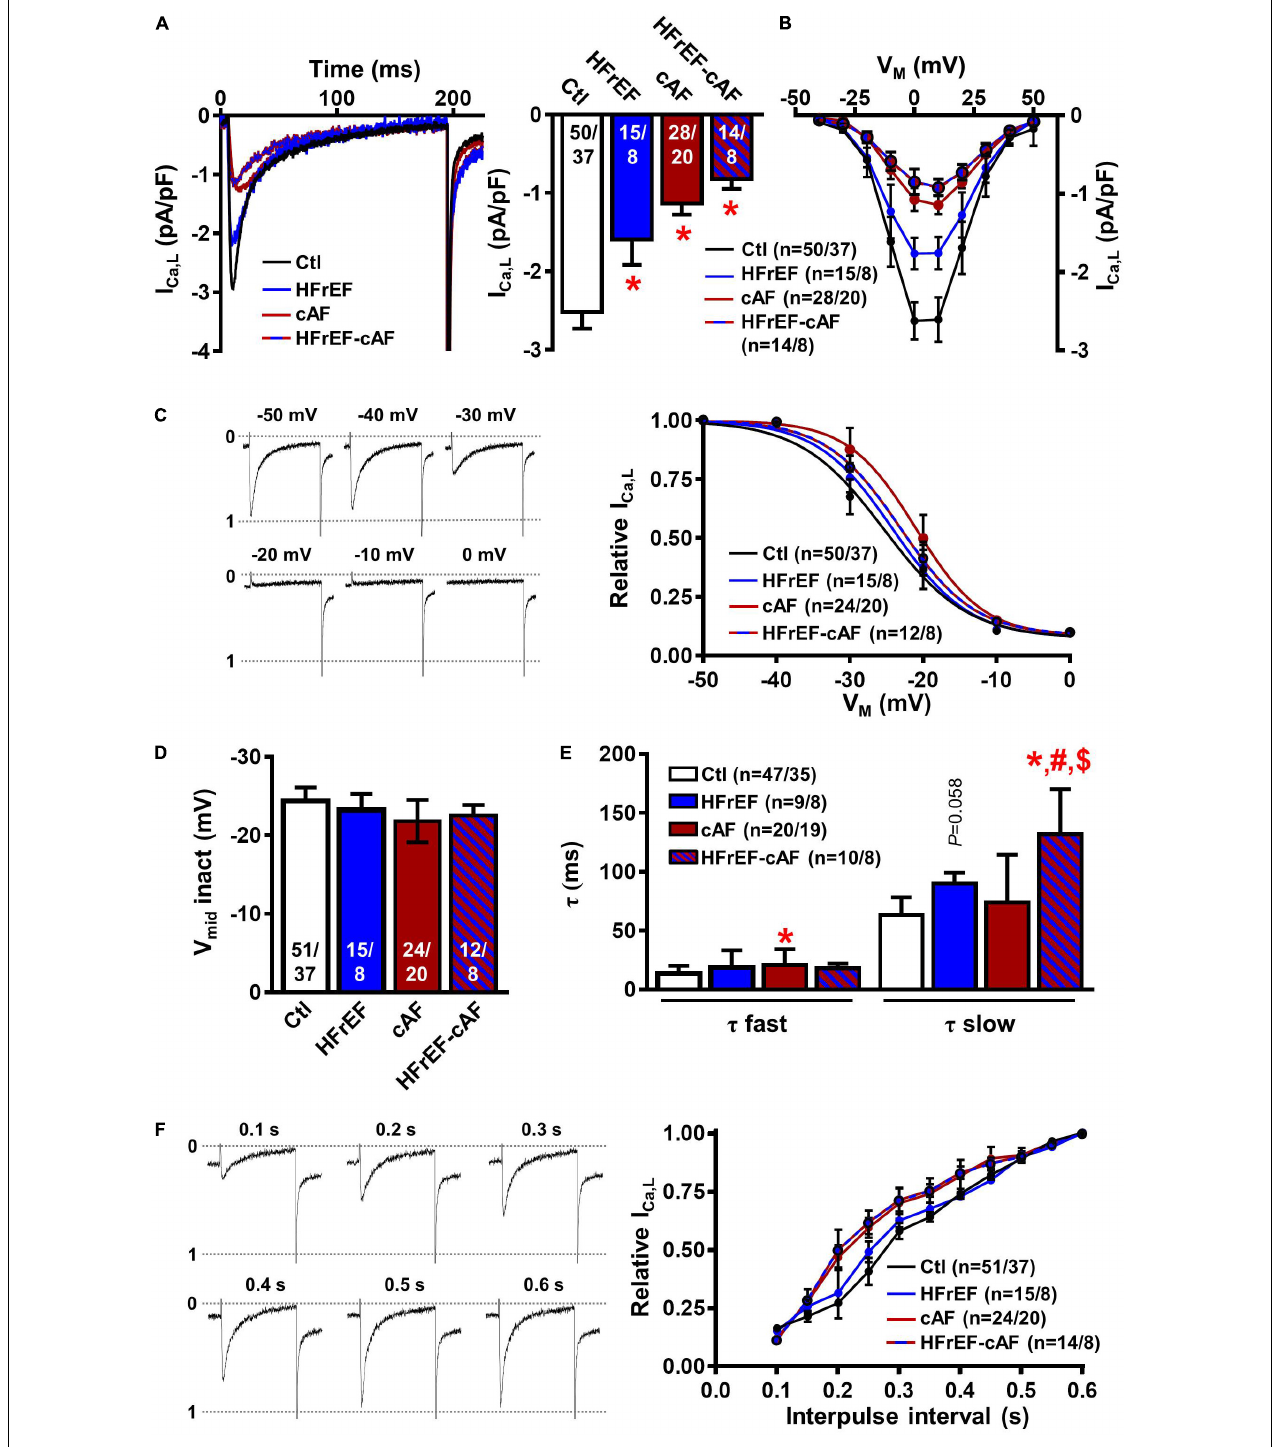
FIGURE 3 | L-type Ca 2 + current (I Ca , L ) measurements in isolated human atrial cardiomyocytes. (A) Representative I Ca , L recording during a 200-ms depolarizing pulse to +10 mV in a Ctl (black), HFrEF (blue), cAF (red) or HFrEF-cAF (blue/red) atrial cardiomyocyte (left) and quantification of I CaL amplitude (right). (B) Current-voltage relationship of peak I Ca , L . (C) Representative examples of I Ca , L inactivation protocol (left) and voltage dependence of inactivation (right) (D) midpoint of inactivation in Ctl, HFrEF, cAF and HFrEF-cAF patients. (E) Fast and slow time constants of inactivation during a depolarization to +10 mV in Ctl, HFrEF, cAF and HFrEF-cAF patients. (F) Representative examples (left) and quantification (right) of I Ca , L recovery from inactivation with various interpulse intervals. Numbers in bars indicate number of cells/number of patients. ∗ indicates P < 0.05 vs. Ctl, # indicates P < 0.05 vs. HFrEF, $ indicates P < 0.05 vs. cAF.